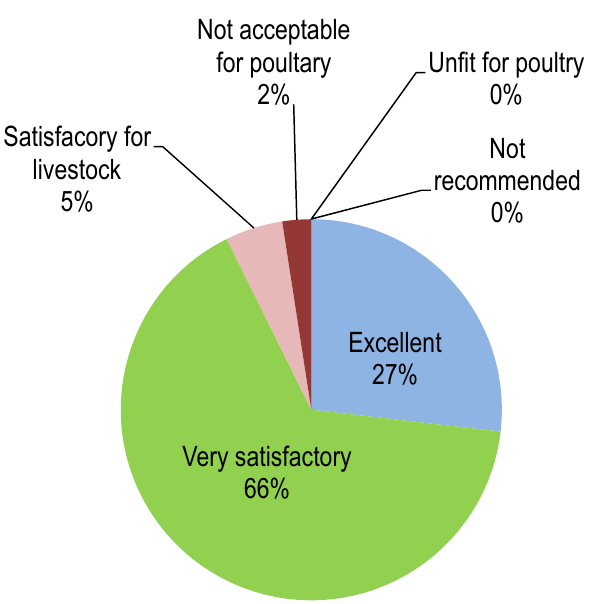
Fig. 10 Classification of groundwater samples for livestock in the study